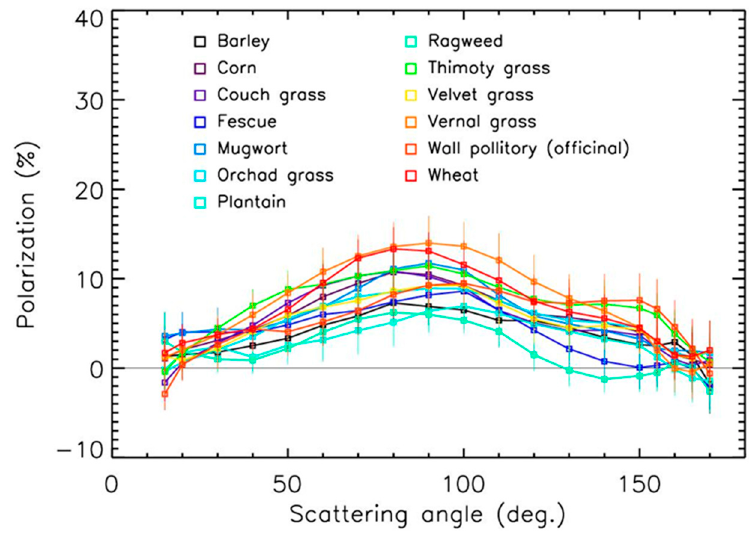
Figure 4. Polarization curves in the red domain for grass and weed pollens.